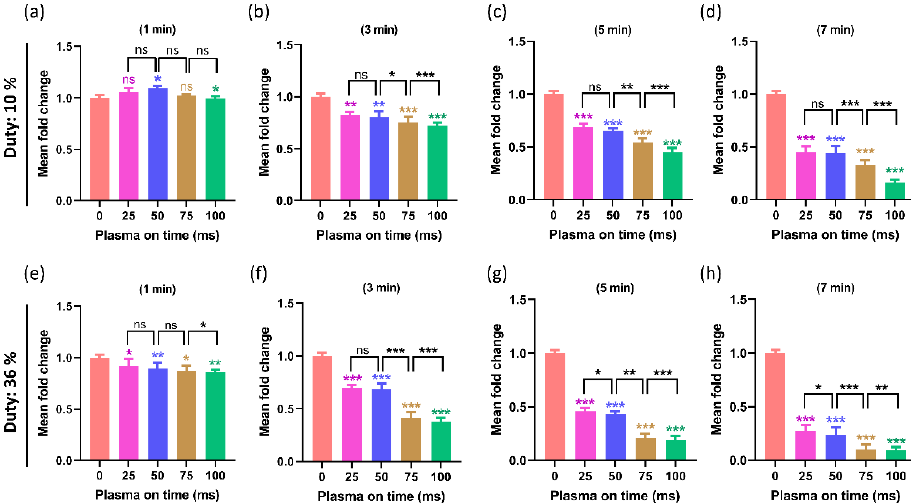
Figure 9. The U87 ‐ MG (brain cancer) cell line’s viability as measured 24 h after (PTM) treatment. The viability was observed under two different duty ratios: ( a – d ) when the duty ratio was fixed at 10% and ( e – h ) when the duty ratio was fixed at 36%. Only the plasma on ‐ time varied for each duty ratio (25, 50, 75, and 100 ms), whereas the treatment time remained the same at 1, 3, 5, and 7 min. It was found that the viability declines between 25 ms and 50 ms plasma on time were non ‐ significant in a 10% duty ratio but significantly decreased in a 36% ratio. It has been noted that, even when the duty ratio and treatment time were fixed, increasing the plasma on ‐ time caused the viability of U87 ‐ MG cells to further decrease. The significance was calculated using Microsoft Excel (MS Office 365), while the differences between the treatment groups are indicated by * p < 0.05, ** p < 0.01, *** p < 0.001, ns—not significant.